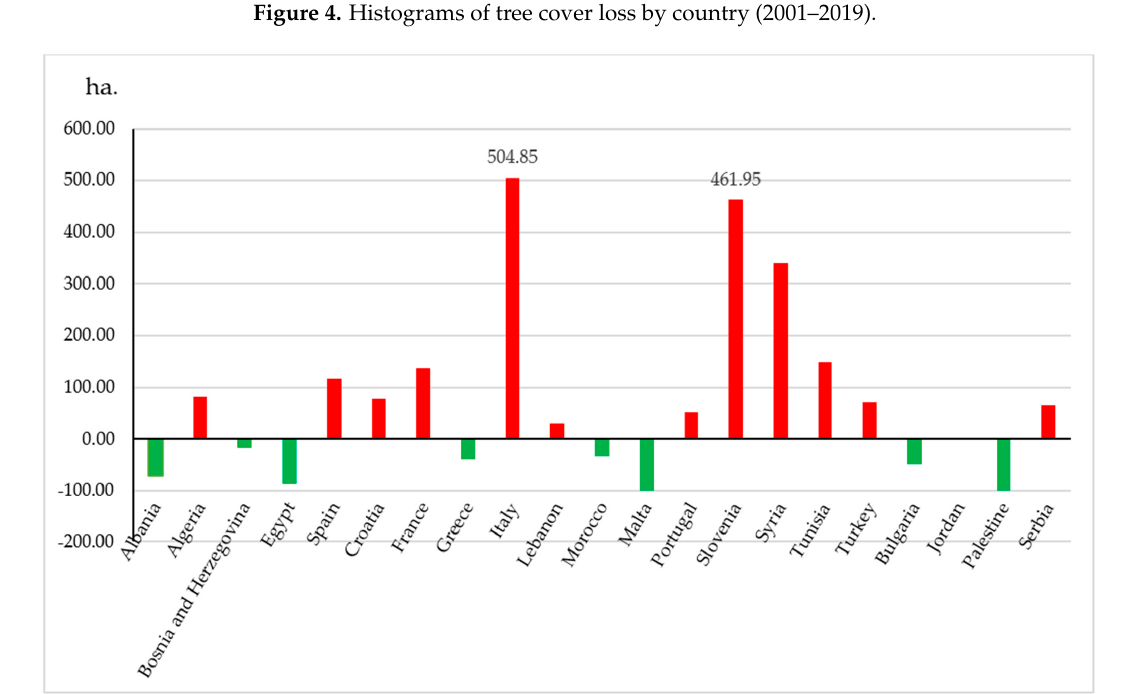
Figure 5. Evolution of the Tree Cover Loss Rate (2019 vs.